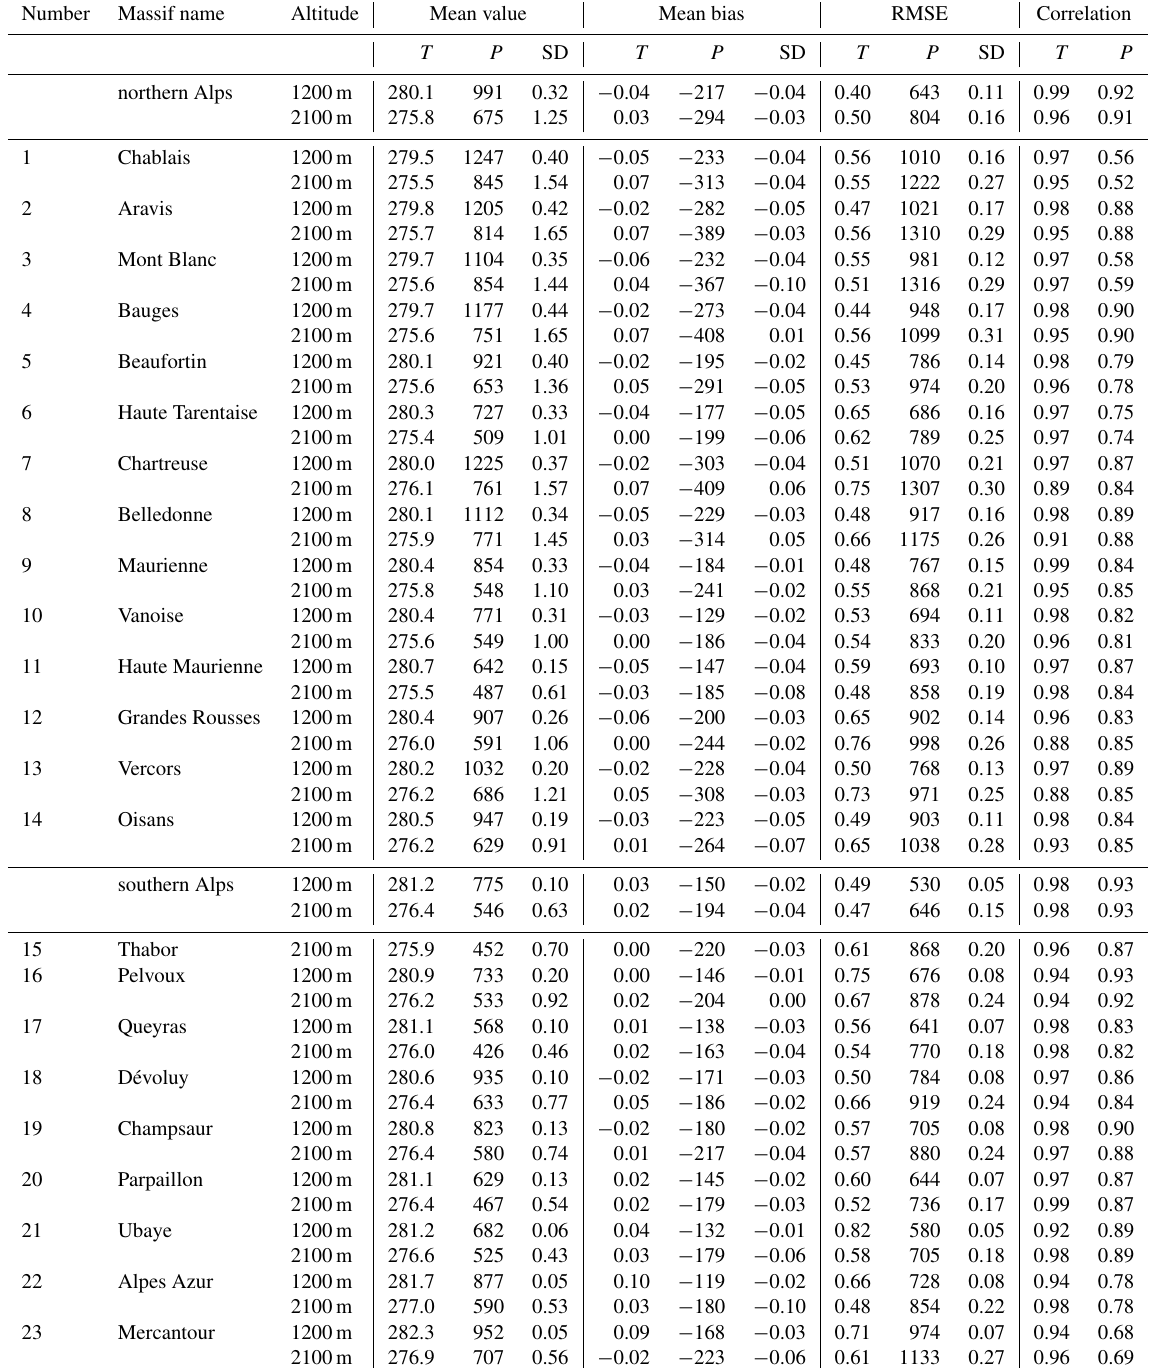
Table 3. Mean values and scores for the ADAMONT-adjusted RCM L. 1980–2010 simulation compared to SAFRAN over the period 1980– 2010 for each massif of the French Alps (massif numbers indicated in Fig. 3) and for the northern and southern Alps at 1200 and 2100m elevation: mean annual temperature ( T , in K) and precipitation ( P , in kgm − 2 yr − 1 ), mean winter (DJFMAM) snow depth (SD, in m); mean annual bias of T and P , mean winter bias of SD; annual root mean square error (RMSE) of T and P , winter RMSE of SD; and annual correlations of T and P